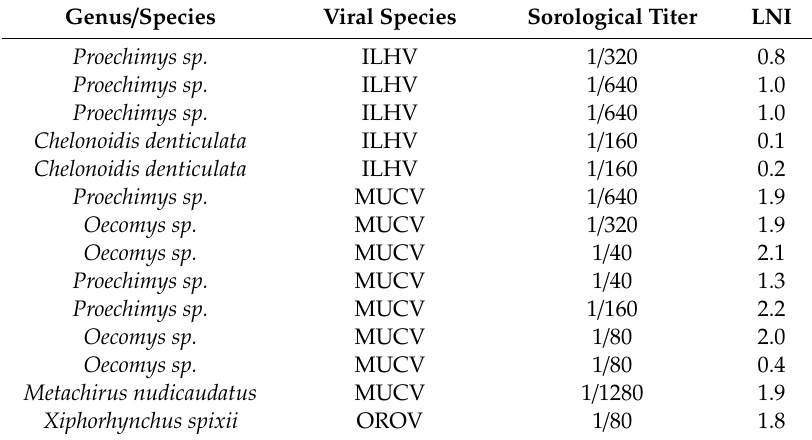
Table A2. Log Neutralization Index (LNI) obtained from NT (Neutralization Test) performed with samples and serological titers to referred viruses, from wild vertebrates captured at Caxiuan ã National Forest, between 2014 and